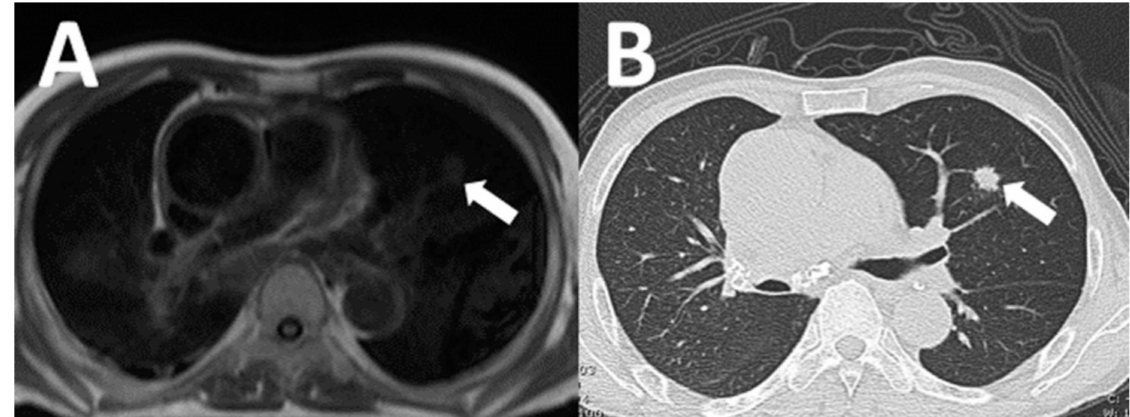
Figure 3. A 72-year-old man underwent CMR to evaluate myocardial viability. Incidentally detected lung nodule on axial black blood image cardiac MRI ( A : arrow). Subsequent CT chest demonstrated speculated lung nodule ( B : arrow) and was consequently diagnosed as primary lung cancer by CT-guided lung biopsy.